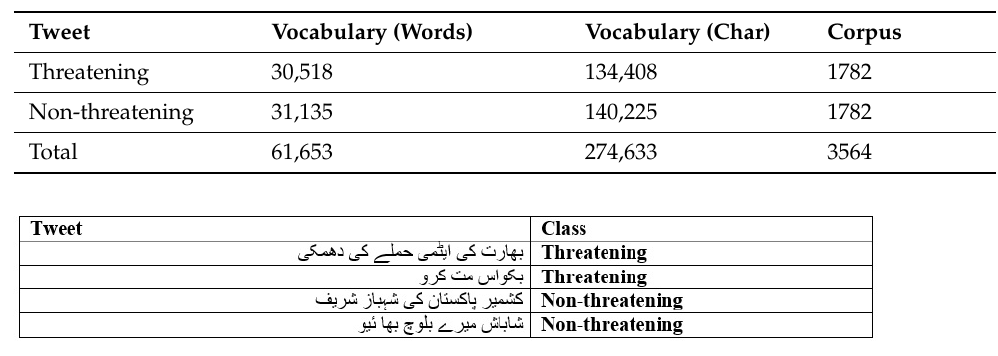
Figure 2. Examples from the dataset containing tweets from the threatening vs. non-threatening